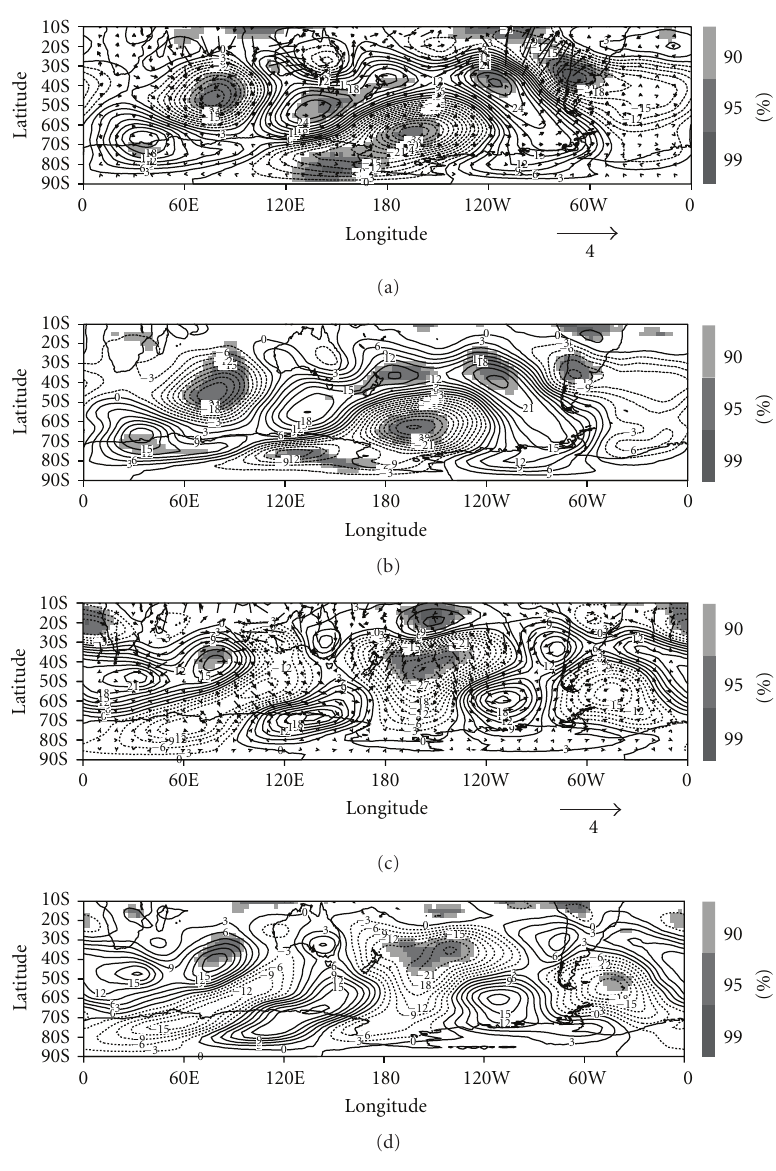
Figure 5: Stationary wave geopotential height (m) in JJA for: (a) anomaly for weak HC cases at 200hPa with Takaya and Nakamura [29] wave activity flux vectors (unit: m 2 s − 2 ), (b) anomaly for weak HC cases at 500hPa, (c) anomaly for strong HC cases at 200 hPa with Takaya and Nakamura [29] wave activity flux vectors (unit: m 2 s − 2 ), and (d) anomaly for strong HC cases at 500 hPa. The contour interval is 3 m and the statistically significant values at the 90%, 95%, and 99% levels according to a two-tailed Student’s t -test are shaded in grey scale (see vertical